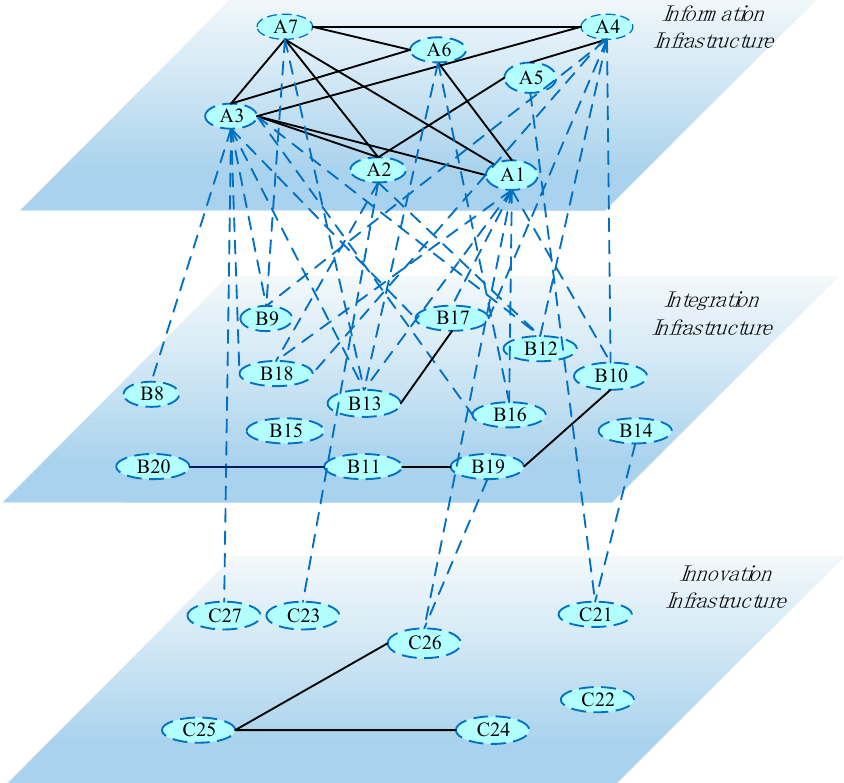
Figure 4. Reciprocal NI Projects.